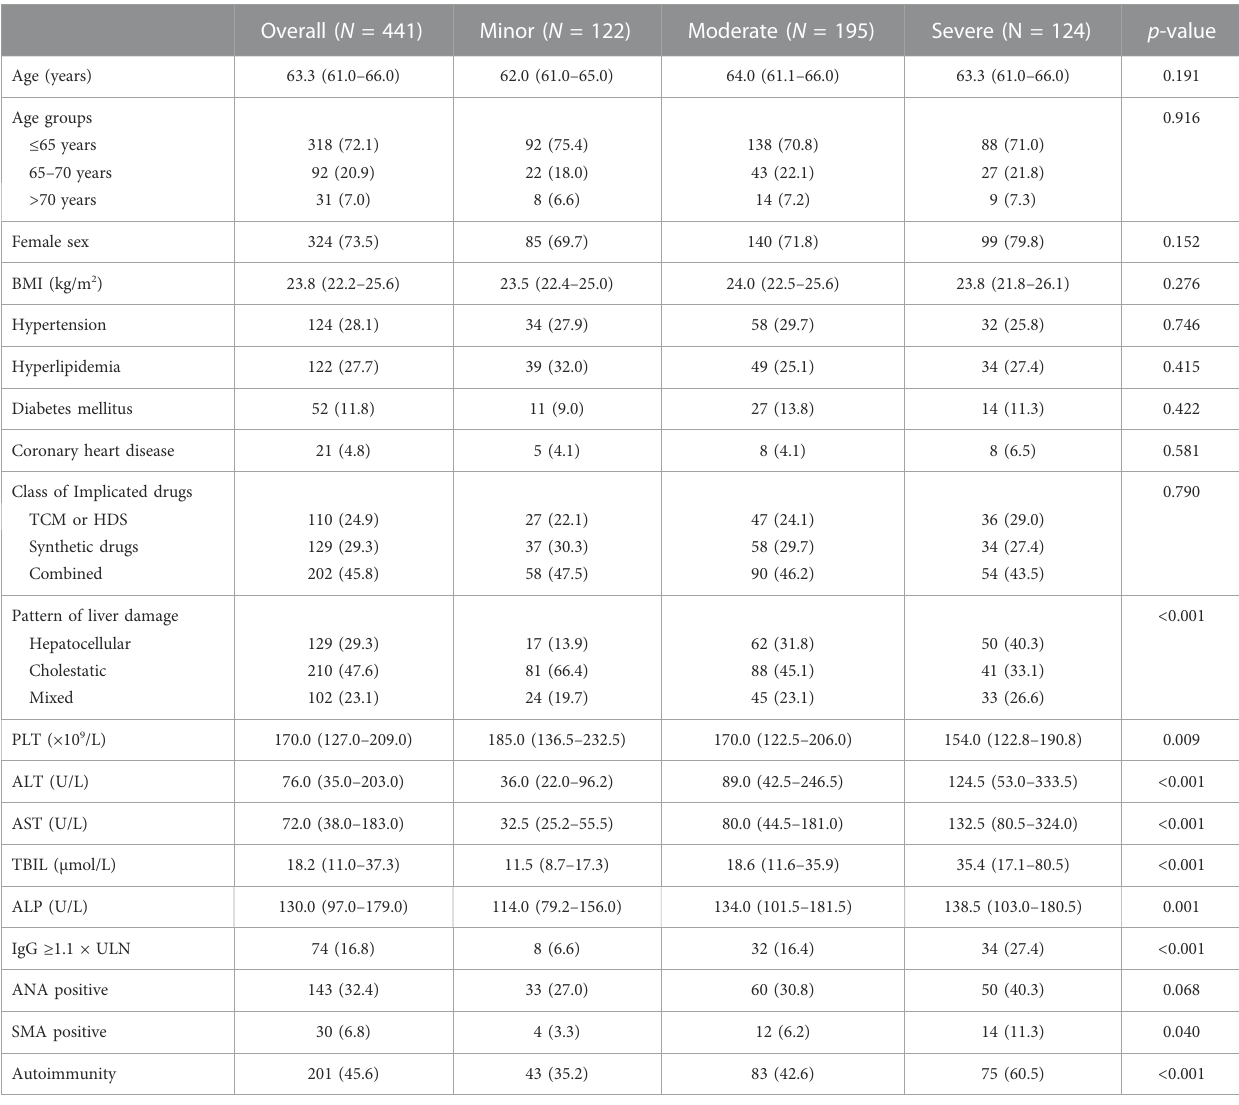
TABLE 1 Clinical characteristics strati fi ed by hepatic in fl